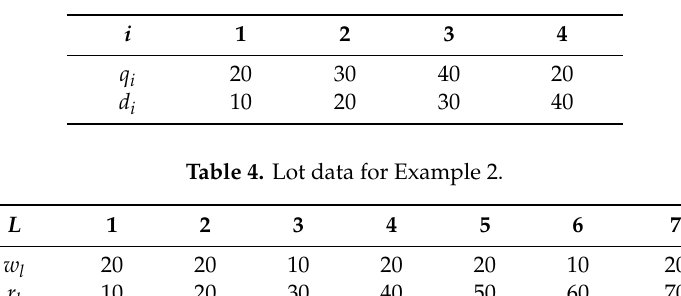
Table 3. Order data for Example 2.